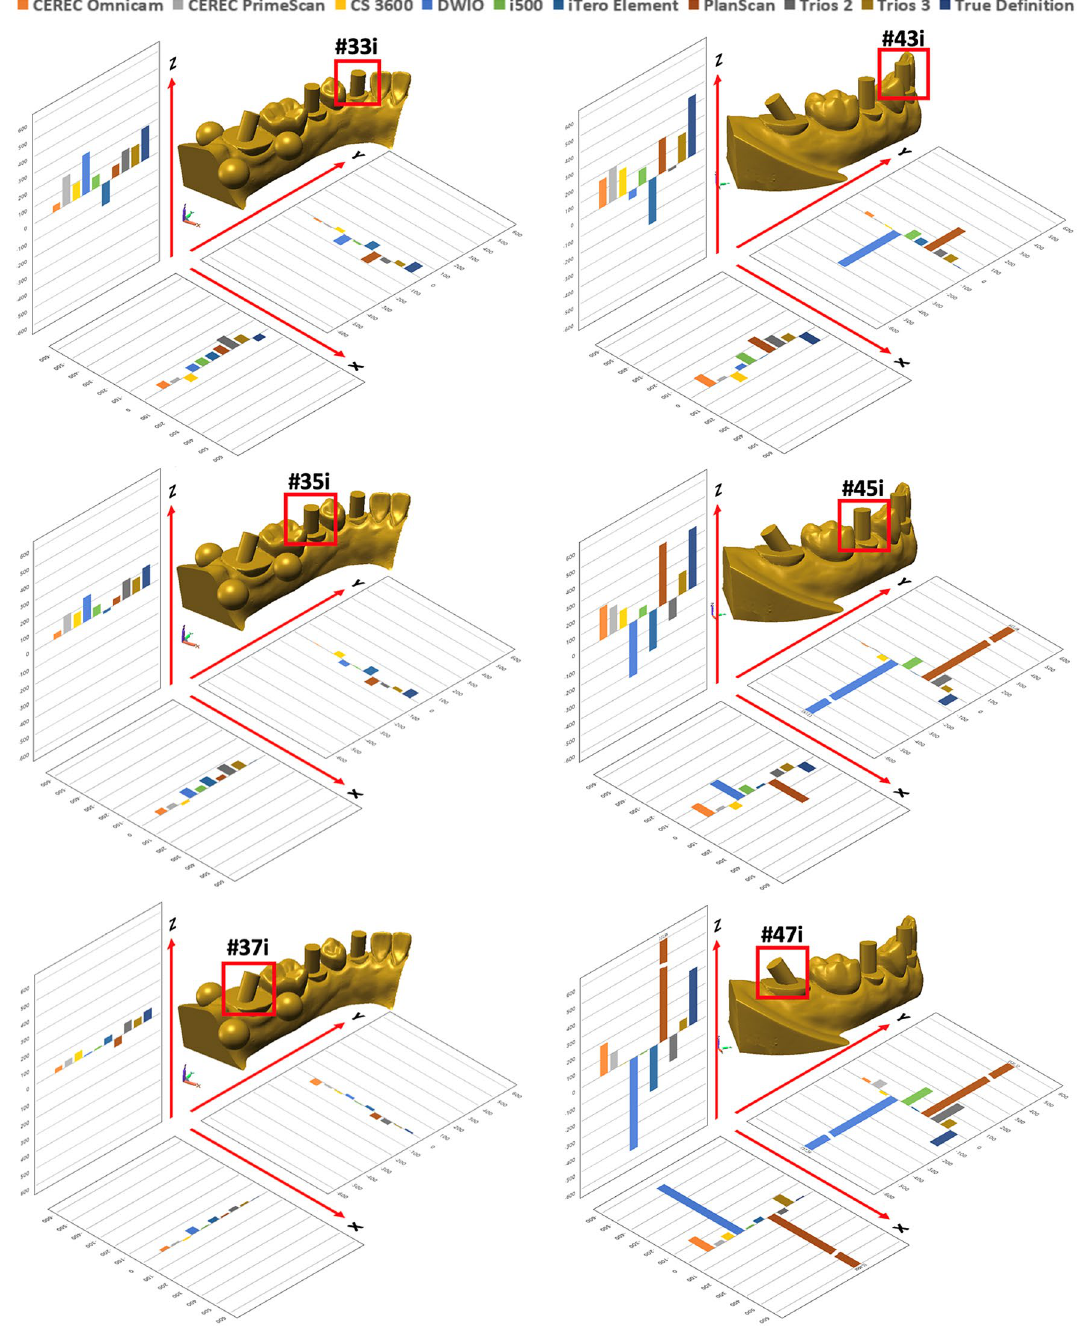
Figure 2. Trueness values (μm) of IOSs at each cylinder position in XYZ